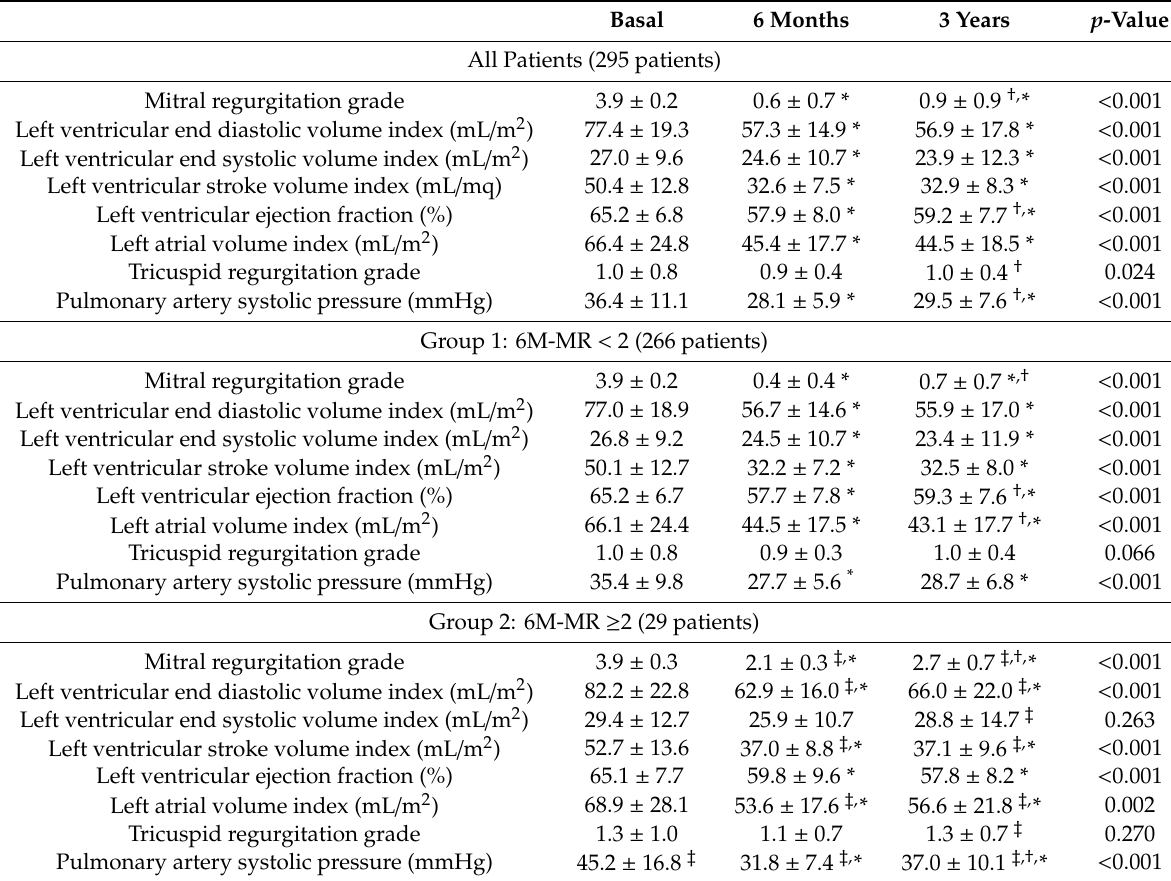
Table 3. Mean ± SD for 2D transthoracic echocardiographic parameters at baseline and at 6 months and 3 years follow-up.